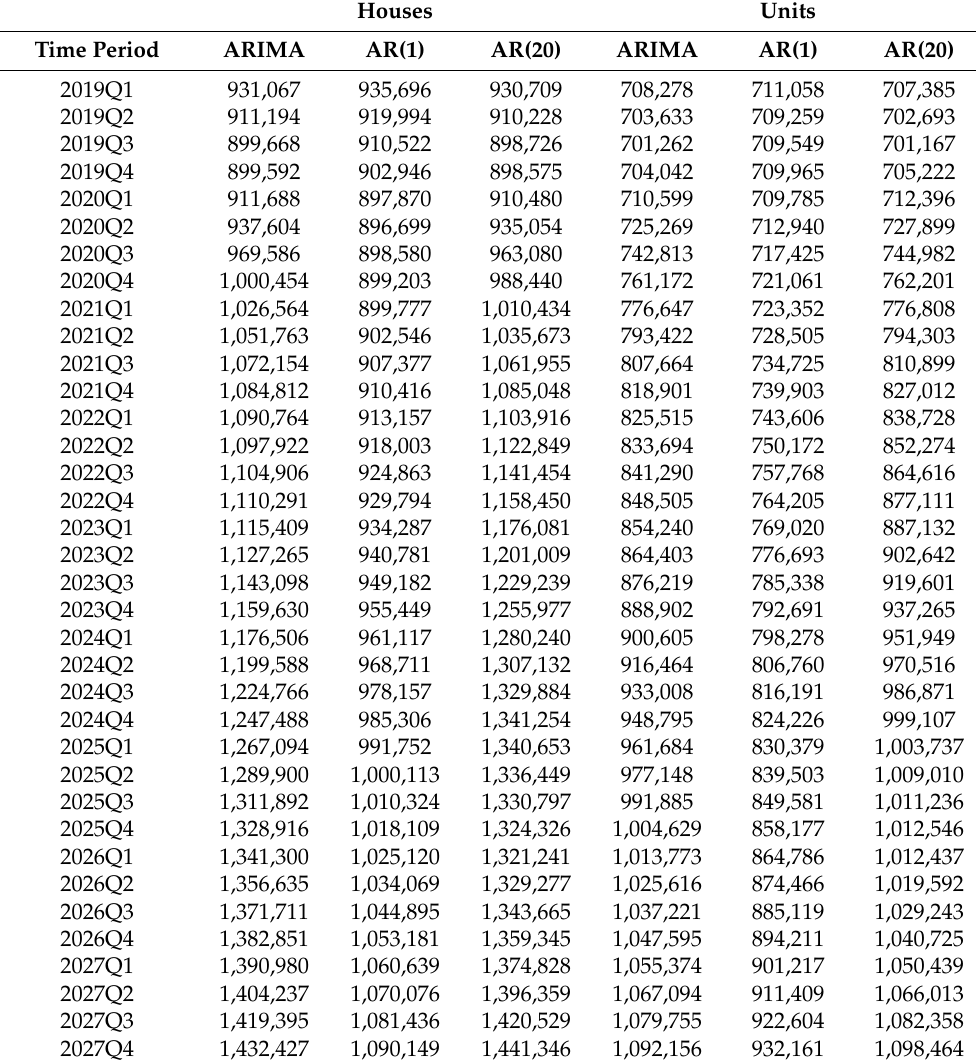
Table 4. Forecasted median prices, Q1 2019–Q4